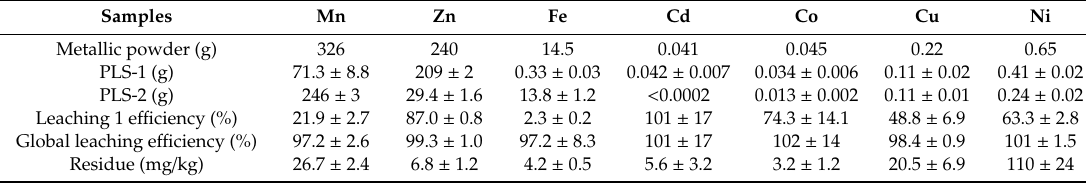
Table 6. Composition of metals in di ff erent fractions for each step of leaching.